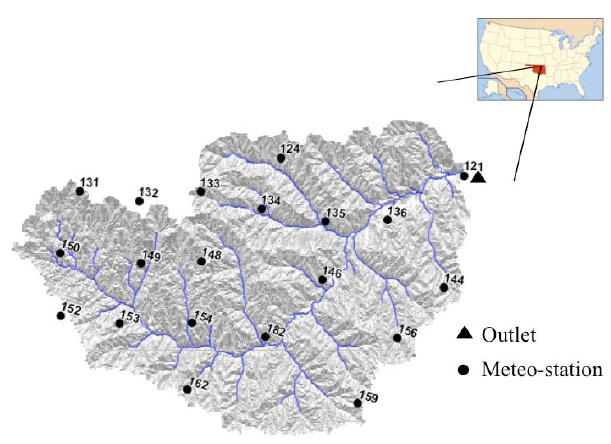
Table 3. Parameter values used in simulation.